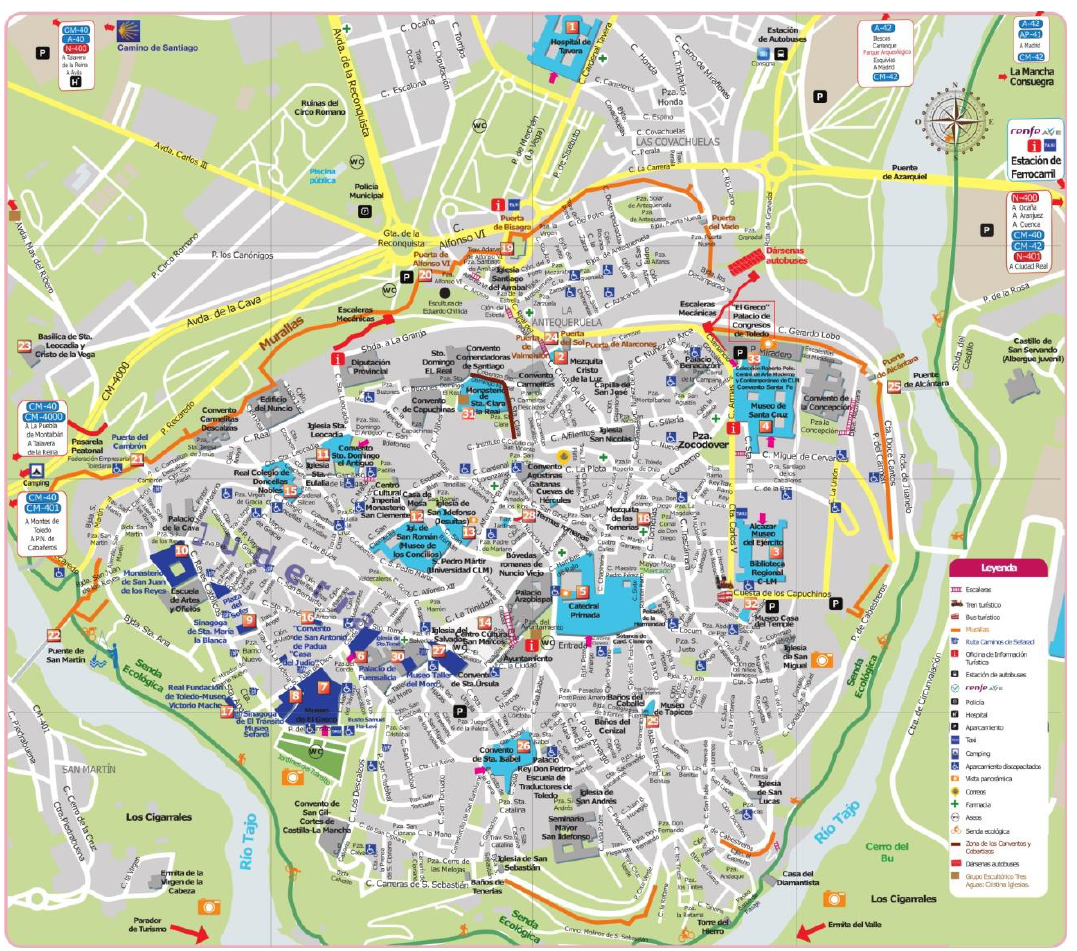
Figure A1. Official tourist map of Toledo. Source: https://turismo.toledo.es/. Figure A1. O ffi cial tourist map of Toledo. Source: https: // turismo.toledo.es /